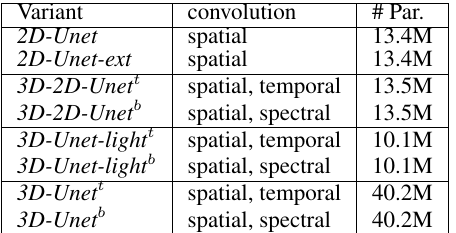
Table 2. Different network variants, dimensions in which the